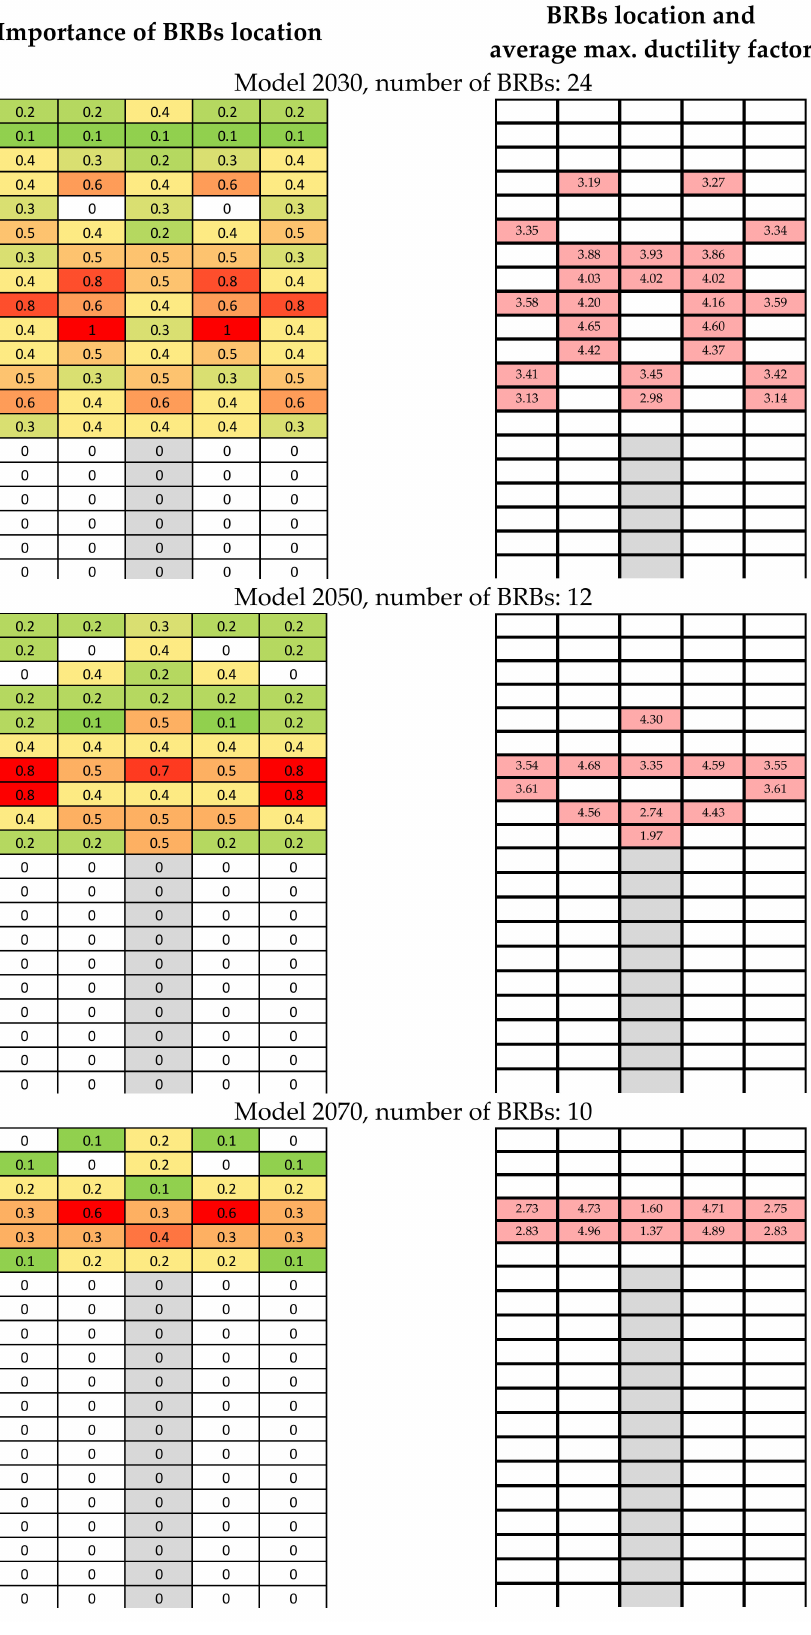
Figure 21. Implementation of BRBs placement for 20 stories based on optimization under 10 input